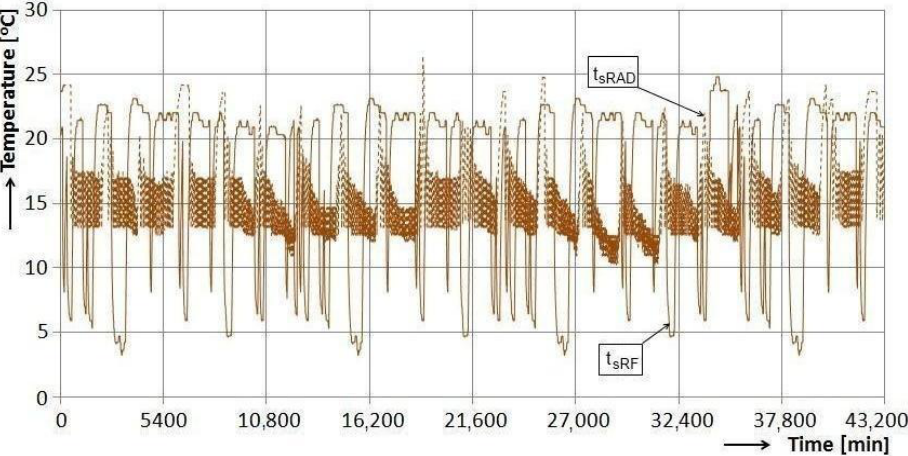
Figure 8. Heat source temperature evolution during heating operation.